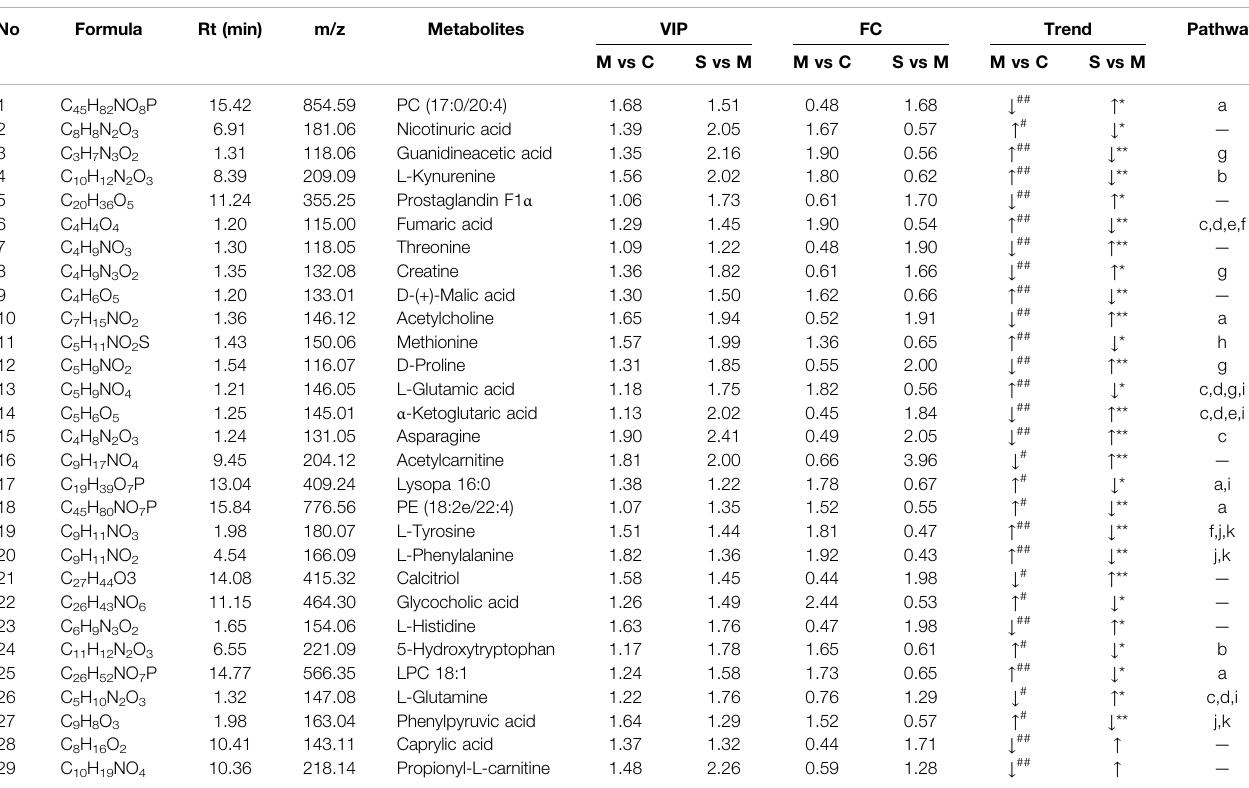
TABLE 3 | The differential metabolites in serum after SHYS treatment. No